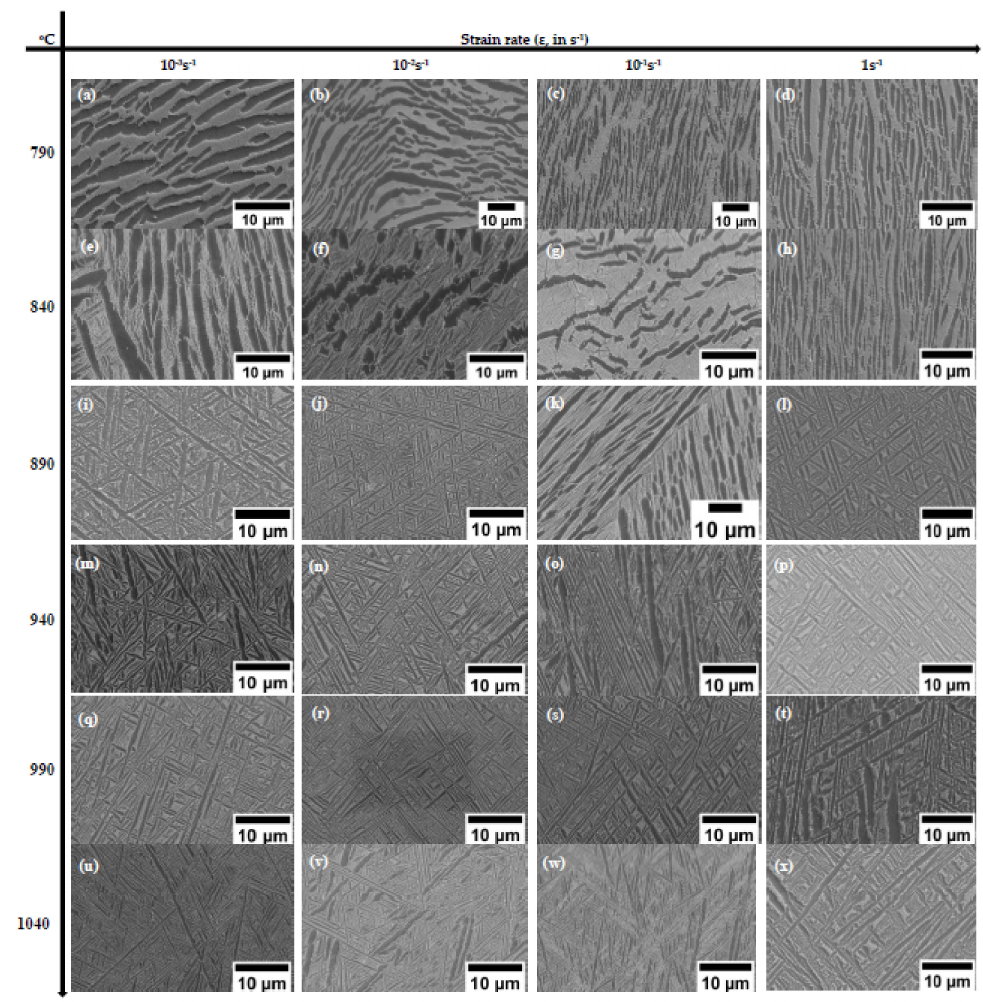
Figure 9. ( a – x ) SEM images of microstructures observed during deformations of Ti6Al4V-5Cu alloy at various temperatures and strain